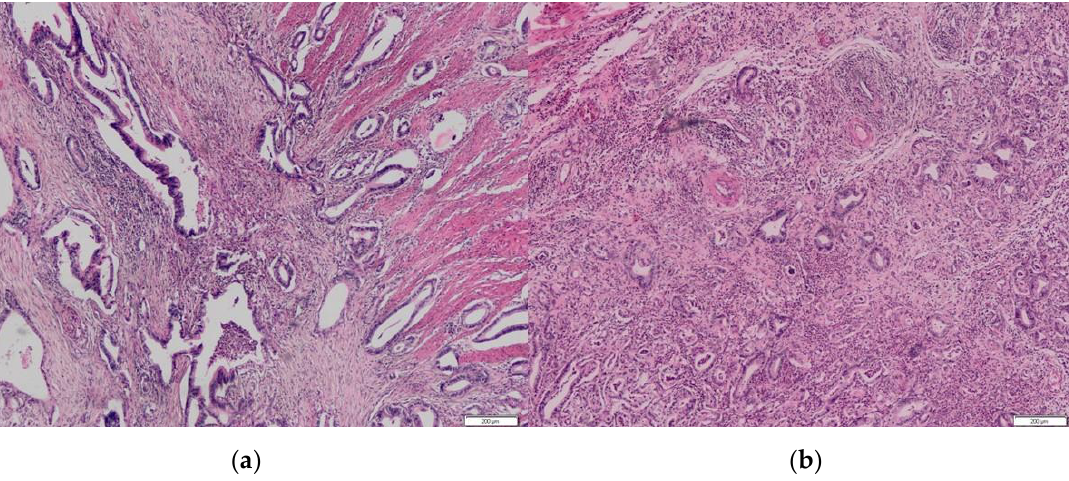
Figure 1. ( a ) Histopathological specimen of pancreatic tissue with well-differentiated ductal adenocarcinoma of pancreatic head. ( b ) Pyloric tissue with well-differentiated ductal adenocarcinoma of pancreatic origin, identic morphology with primary pancreatic tumor. No signs of a primary gastric adenocarcinoma. Hematoxylin/Eosin.